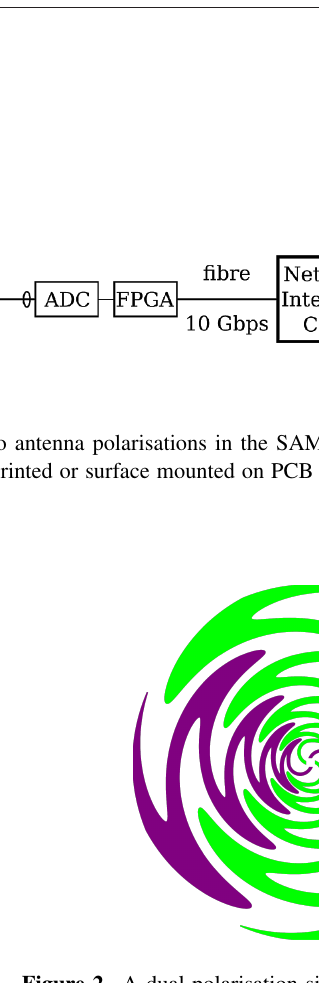
Figure 2. A dual-polarisation sinuous antenna, vertical polari- sation in green and horizontal polarisation in purple. The log- periodic structure of the sinuous antenna o ff ers a relatively small diameter for the low end frequency compared with other anten- nas and enables two polarisations to interleave. An array of sinu- ous antennas will not su ff er from internal reflections due to their planar shape. At the desired maximum frequency, 40 GHz, the central feed region becomes very small making the design of the feed network the most complex part of the design. The feed de- sign is omitted here so as not to prejudice future